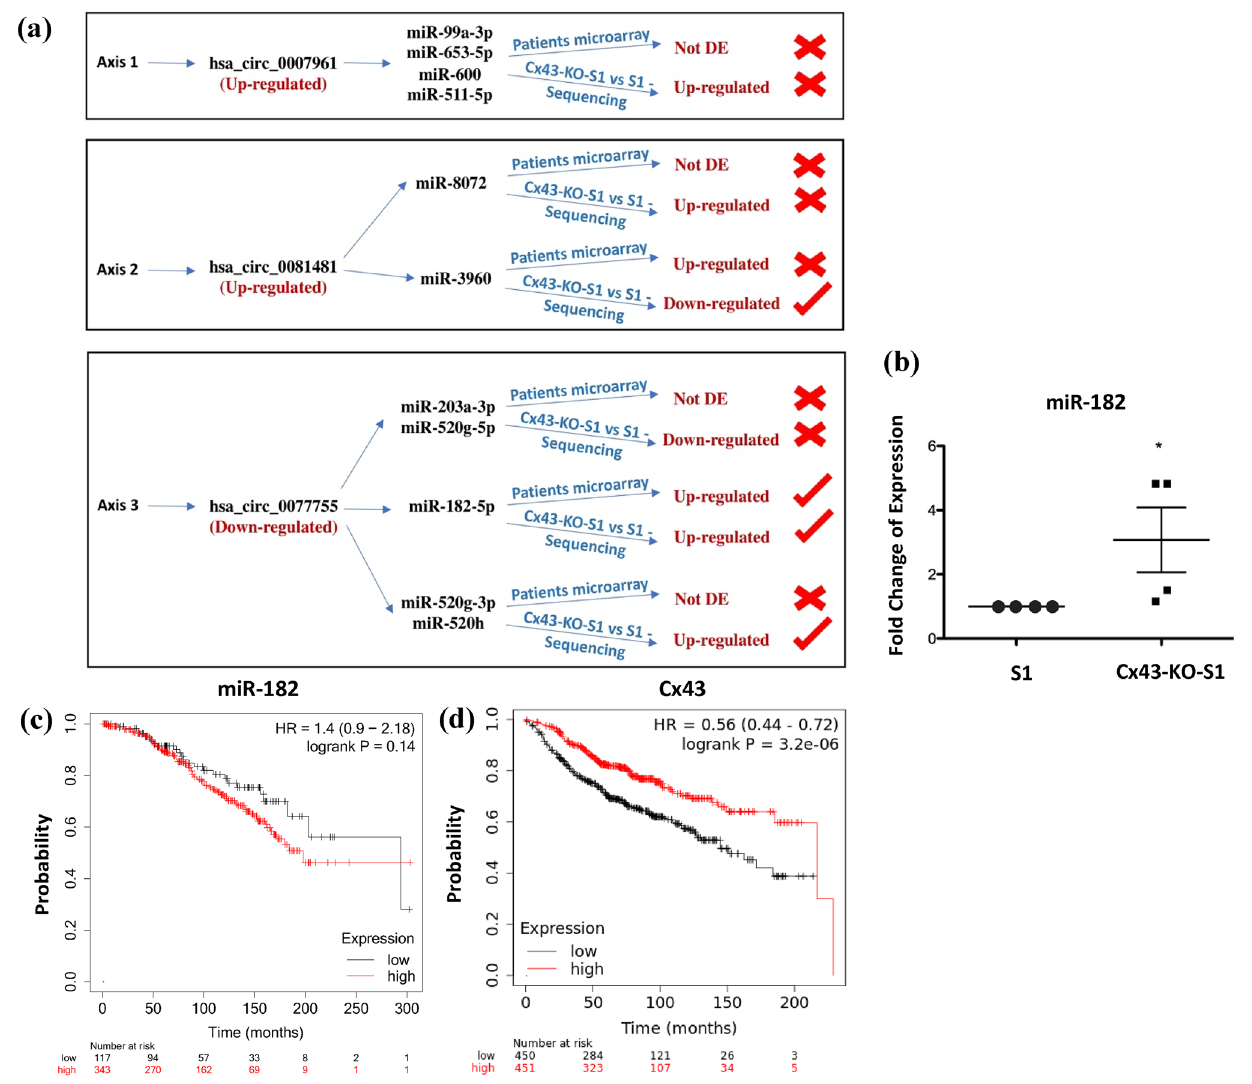
Figure 5. Selection of one validated mRNA-circRNA-miRNA breast cancer initiation risk-assessment axis. ( a ) Comparative flow chart representing the dysregulation patterns of the validated circRNAs and that of their target miRNAs, based on (i) miRNA sequencing in Cx43-KO-S1 cells compared to S1 cells (shown in Fig. 3) and (ii) tumor-associated miRNAs from microarrays of early-stage Lebanese breast cancer patient cohort as reported in Nassar et al. 47 (shown in Table 1). Only Cx43/has_circ_0077755/miR-182 axis exhibits the expected inverse dysregulation pattern between circRNA and their target miRNAs in both cells and patients (when circRNA is down-regulated, its MRE should be up-regulated, and vice versa). ( b ) RT-qPCR further confirmed the upregulation of miR-182 in four samples of Cx43-KO-S1 cells as compared to S1 counterparts using RNU6B as an endogenous control. * denotes a p.value < 0.05 for Cx43-KO-S1 versus S1 cells using one-tailed unpaired T-test. ( c ) Using METABRIC breast cancer miRNA dataset in the Kaplan–Meier Plotter 50 , the survival analysis for miR-182 in 460 patients with grade II breast tumors was plotted. miR-182 seems to associate with poor prognosis when up-regulated in grade II breast tumors. ( d ) Using all breast cancer mRNA datasets in the Kaplan–Meier Plotter 50,51 , the survival analysis for Cx43 in 901 patients with grade II breast tumors was plotted. Cx43 seems to associate with poor prognosis when down-regulated . The same was performed for Grade III breast tumors and presented in (Supplementary Fig. 2a,b), where down-regulation of miR-182 and up-regulation of Cx43 seem to associate with poor prognosis in Grade III breast